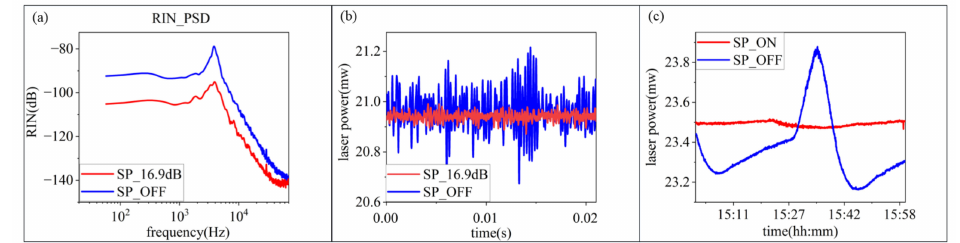
Figure 7. Suppression results of laser source before and after 16.9 dB suppression. ( a ) The PSD of RIN. ( b ) The time domain waveform. ( c ) The long-term intensity